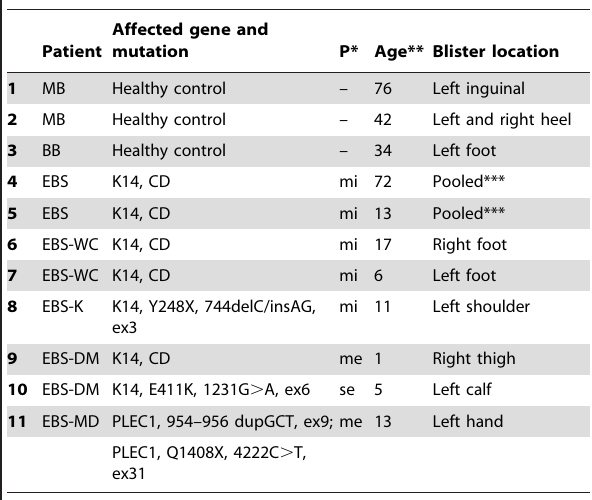
Table 1. Summarized patient